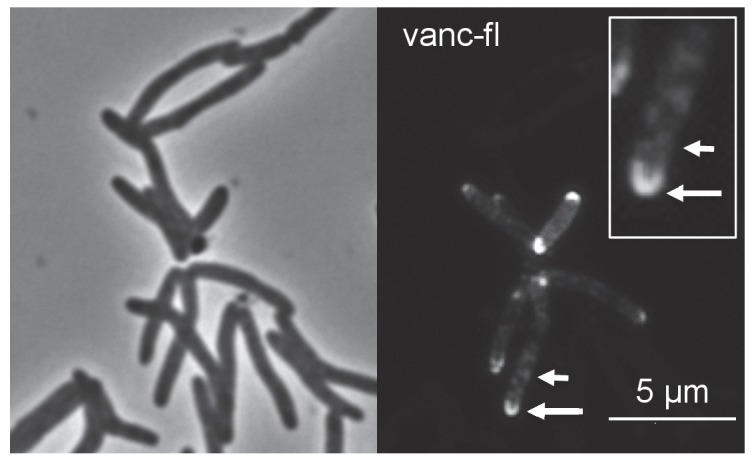
Fluorescent vancomycin (vanc-fl) labeling at poles and sidewall.M. smegmatis were incubated in the fluorescent antibiotic for 3 hr or ~one doubling. Longer arrow, polar labeling. Short arrow, sidewall labeling.10.7554/eLife.37243.024Figure 5—figure supplement 2—source data 1.Conventional fluorescence microscopy images of M. smegmatis labeled with fluorescent vancomycin.